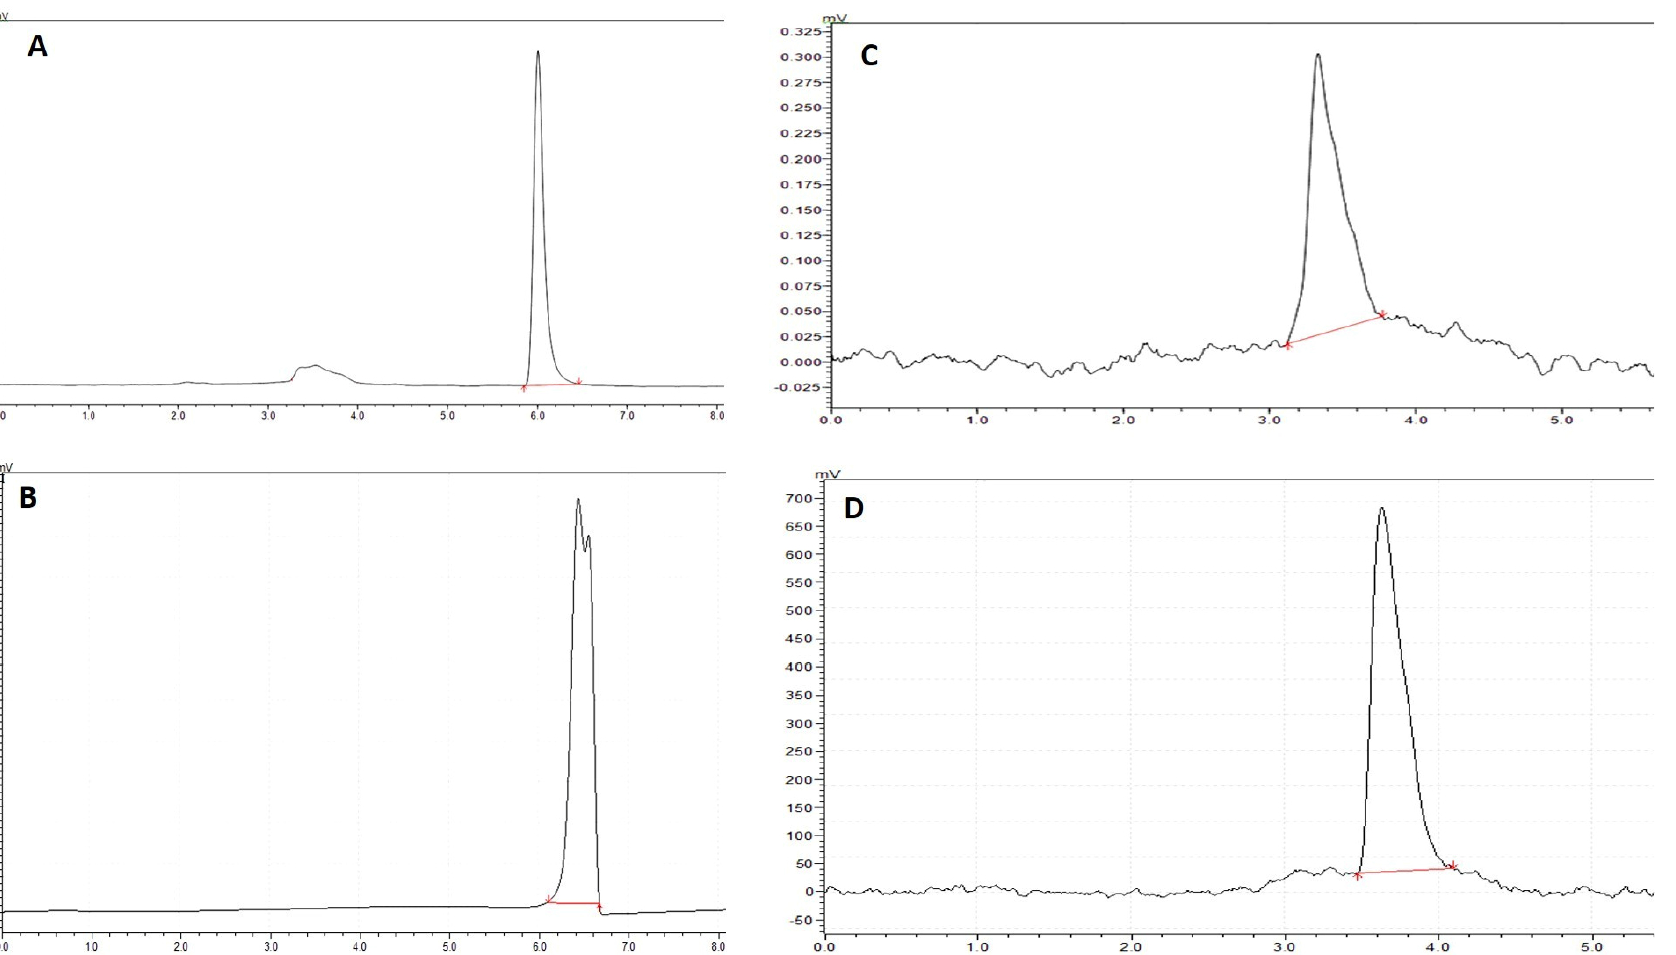
Figure 1. HPLC chromatographs of OPA/NAC derivatized standards and samples. ( A ) Lysine standards (0.25 mmol/L); ( B ) Lysine detection in plasma protein (1:500 dilution); ( C ) N ε -carboxymethyllysine (CML) standards (0.25 mmol/L); ( D ) CML detection in plasma